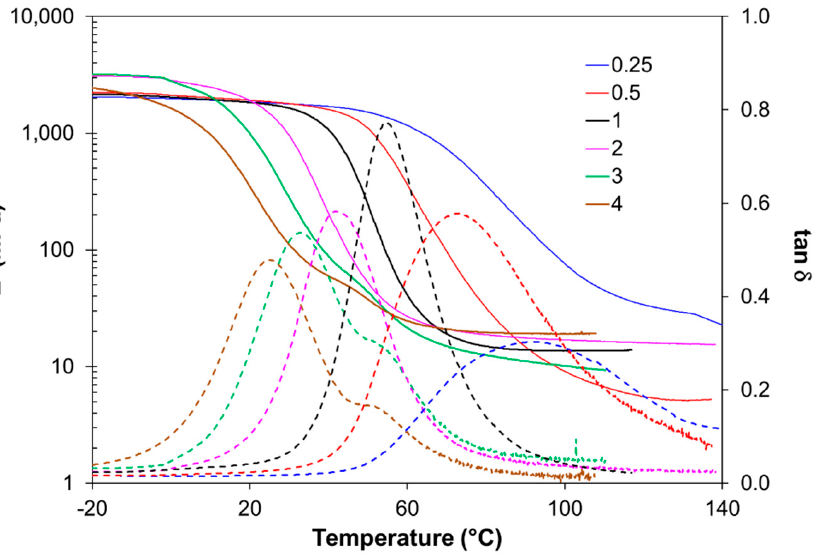
Figure 1. Storage moduli ( E’ ) and tan delta curves of formulations with varying acrylate:epoxy ra ‐